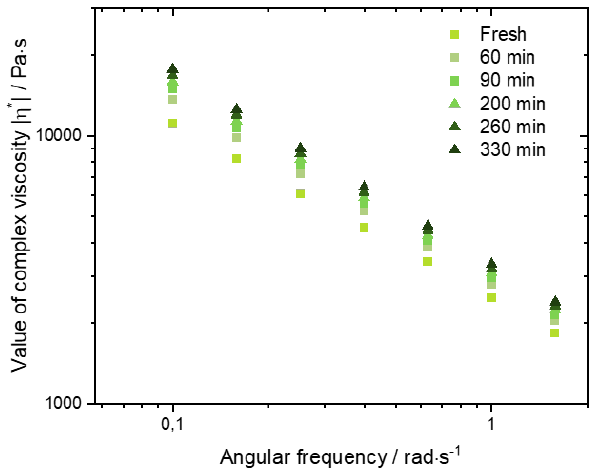
Figure 3. Frequency-dependent value of complex viscosity of a BG–alginate ink in the interval from 0.1 to 1 rad/s for six tested time intervals.